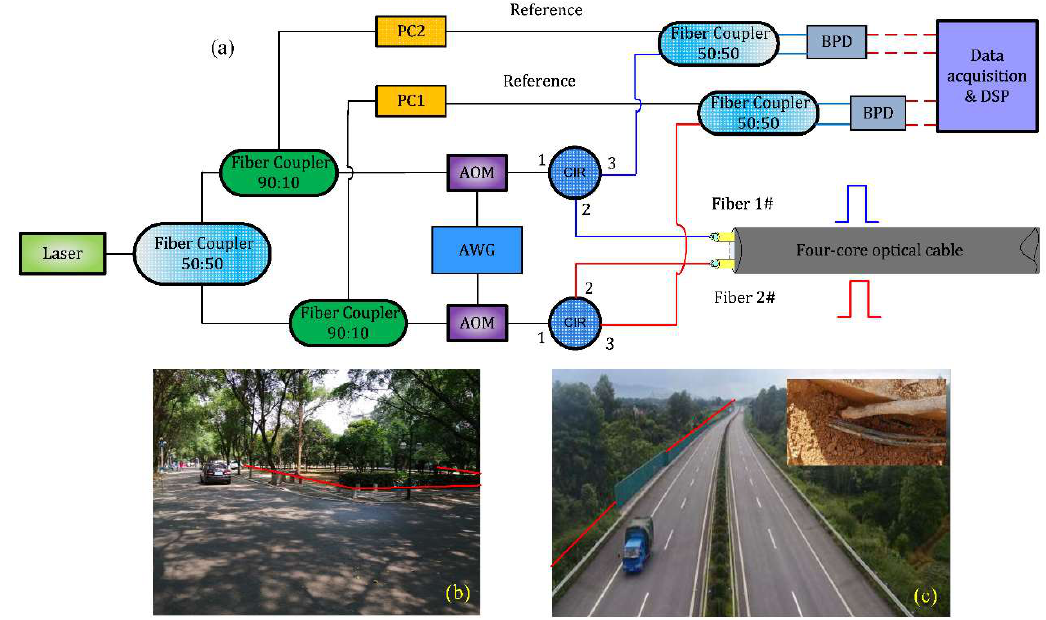
Figure 1. ( a ) Experimental set-up of the DC- ϕ -OTDR, ( b ) Testing on a campus road, and ( c ) Testing on a highway. The red lines in ( b ) and ( c ) respective indicate the approximate positions of the sensing cable experimented in the campus and paved along the highway. The inset in ( c ) is the optical cable buried in the soil over the measured zone.